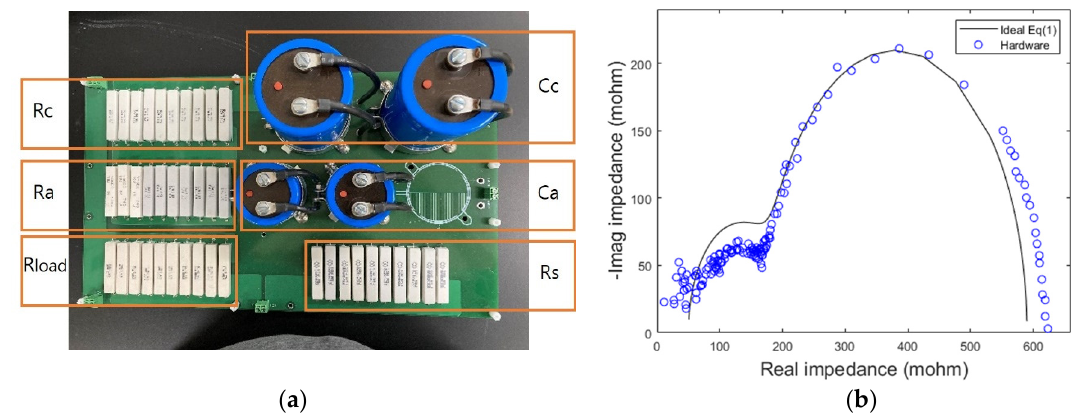
Figure 9. Fuel cell hardware simulator and Nyquist plot from experiments. ( a ) Fuel cell impedance hardware simulator. ( b ) Nyquist plot from experiments.